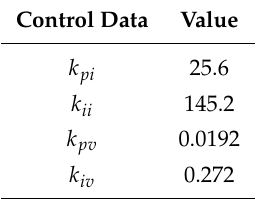
Table A2. Control